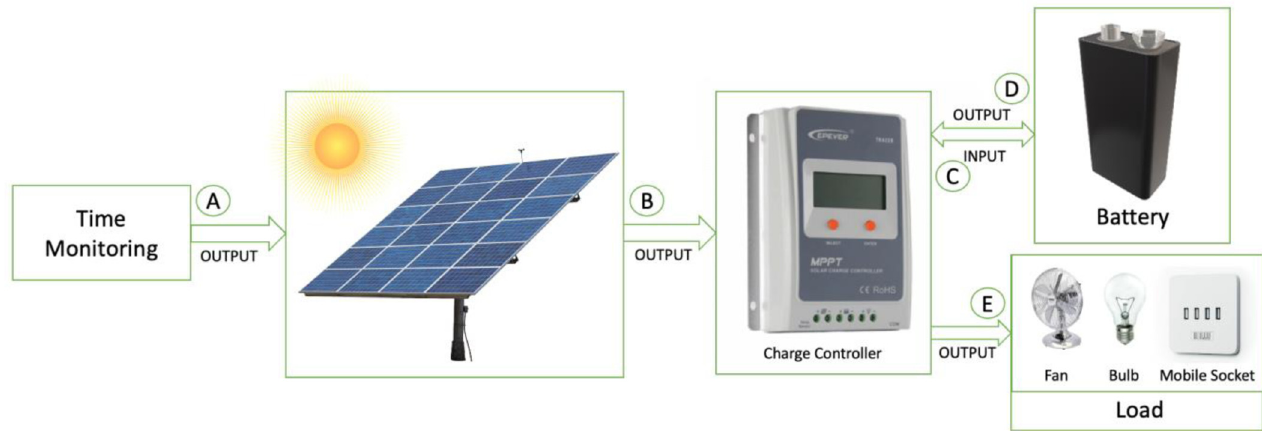
Fig. 1. The fl ow of energy diagram for the household installed at